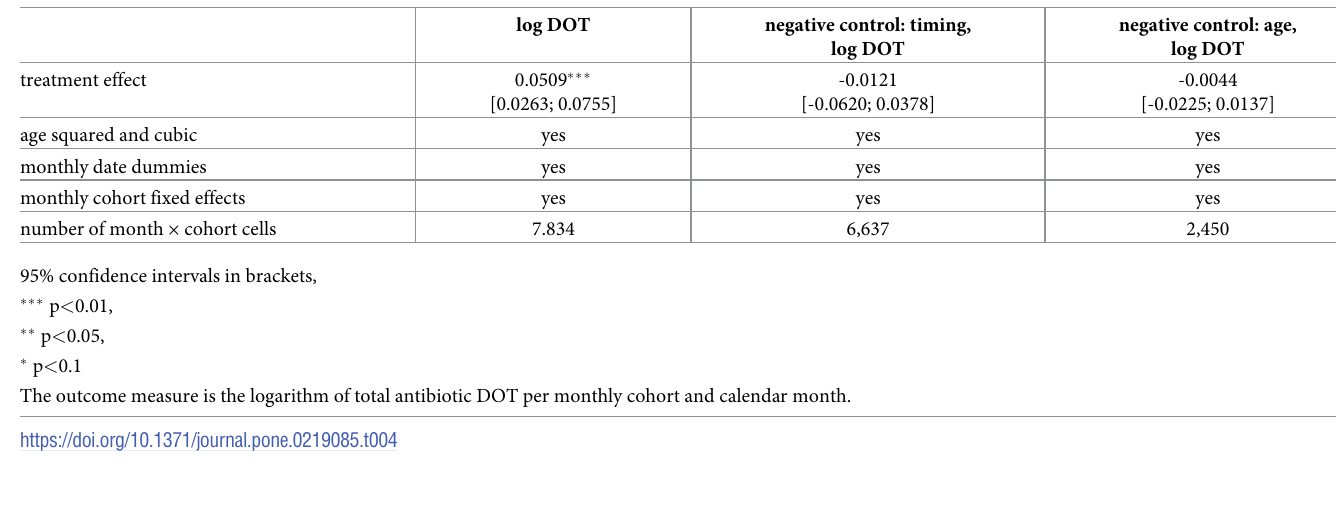
Table 4. Estimated effect of the increased price subsidy on antibiotic use. Baseline results and negative control